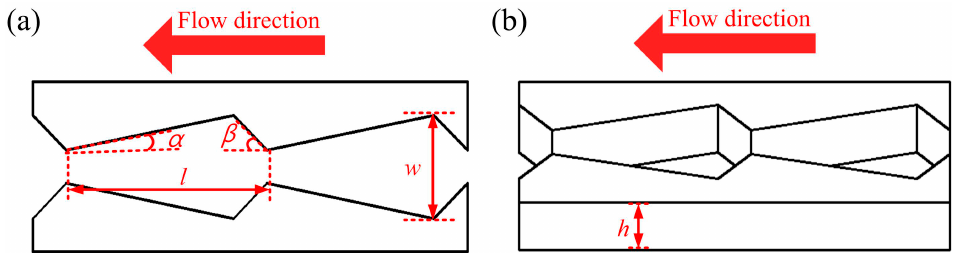
Figure 1. ( a ) The peristome surface of the pitcher plant. ( b ) Schematic diagram of a flat-bottom conical array. ( c ) A typical arrowhead structure that inspired the microstructure design. ( d ) Schematic diagram of arrowhead array.